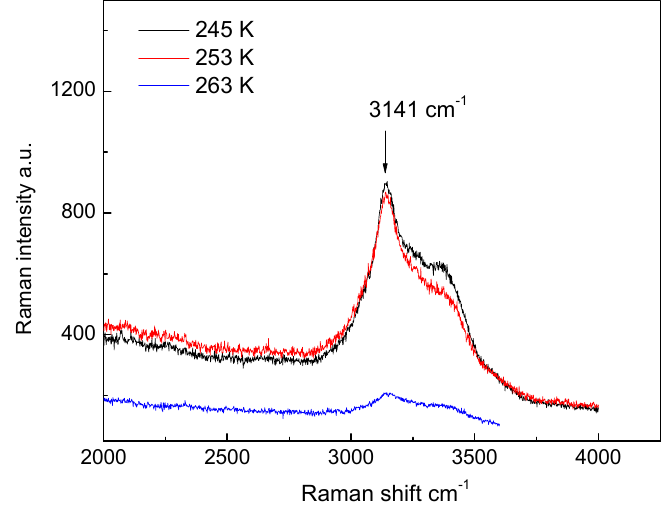
Figure 6. Raman peak of the O–H bond of water molecules after the end of decomposition.